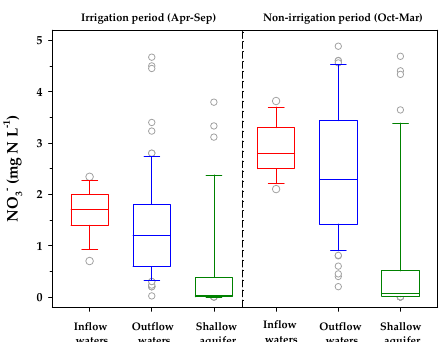
Figure 2. Nitrate concentrations in water imported and exported by the canal network and in the shallow aquifer of the Po di Volano-Sacca di Goro watershed. The central horizontal line in the box is the median, the top and bottom boxes are the 25 th and 75 th percentiles, and the whiskers are the 10 th and 90 th percentiles. Outliers are shown as open circles.